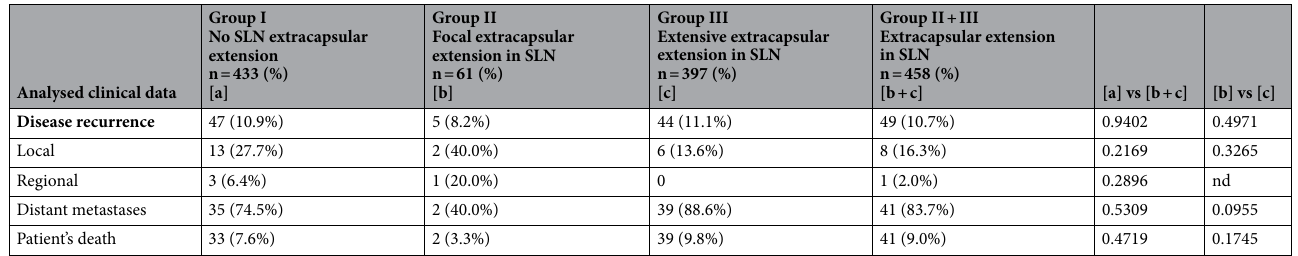
Table 2. Long-term treatment results.